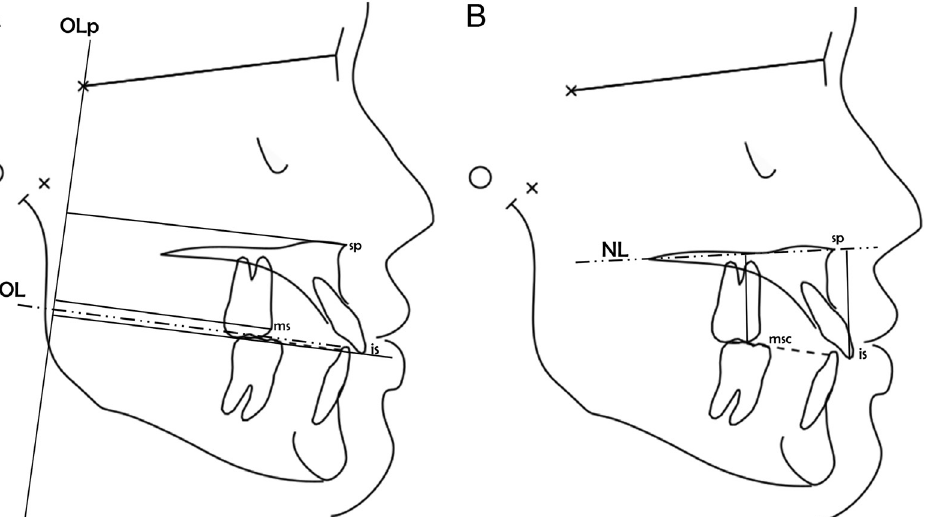
Figure 4. Pancherz analysis landmarks and reference line: is , incisal tip of the most prominent maxillary central incisor; ms , mesial contact point of the maxillary permanent first molar determined by a tangent perpendicular to OL; sp, spinal point of the maxilla jaw base, OL , a line through is and the distobuccal cusp maxillary first permanent molar; OLp, is a line perpendicular to OL through s (sella); NL , nasal line or maxillary plane. SO analysis refer- ence (a): position of the maxillary jaw base (sp/OL ), position of the most prominent central incisor (is/OL ) and position of the left permanent first molar p p (ms/OL ). VO analysis reference (b): position of the maxillary central incisor to the maxillary plane, (is/NL) and position of the permanent first molar cusp p to the nasal line,